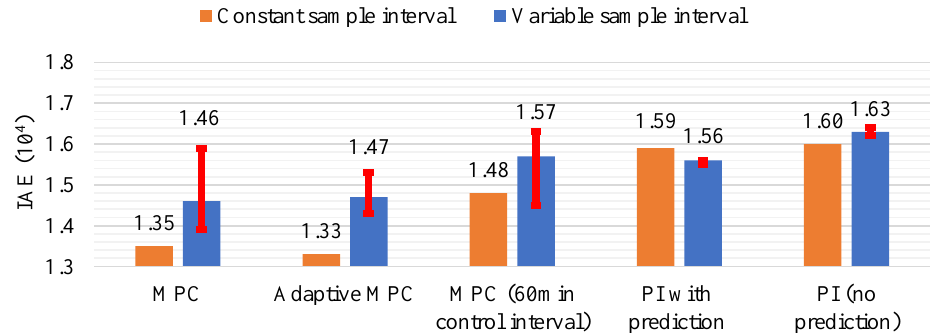
Figure 16. The effect of a variable sampling time (60 ± 15 min) on the controller performance. Results taken as an average of five runs and error bars (red) included to show the variation in IAE.